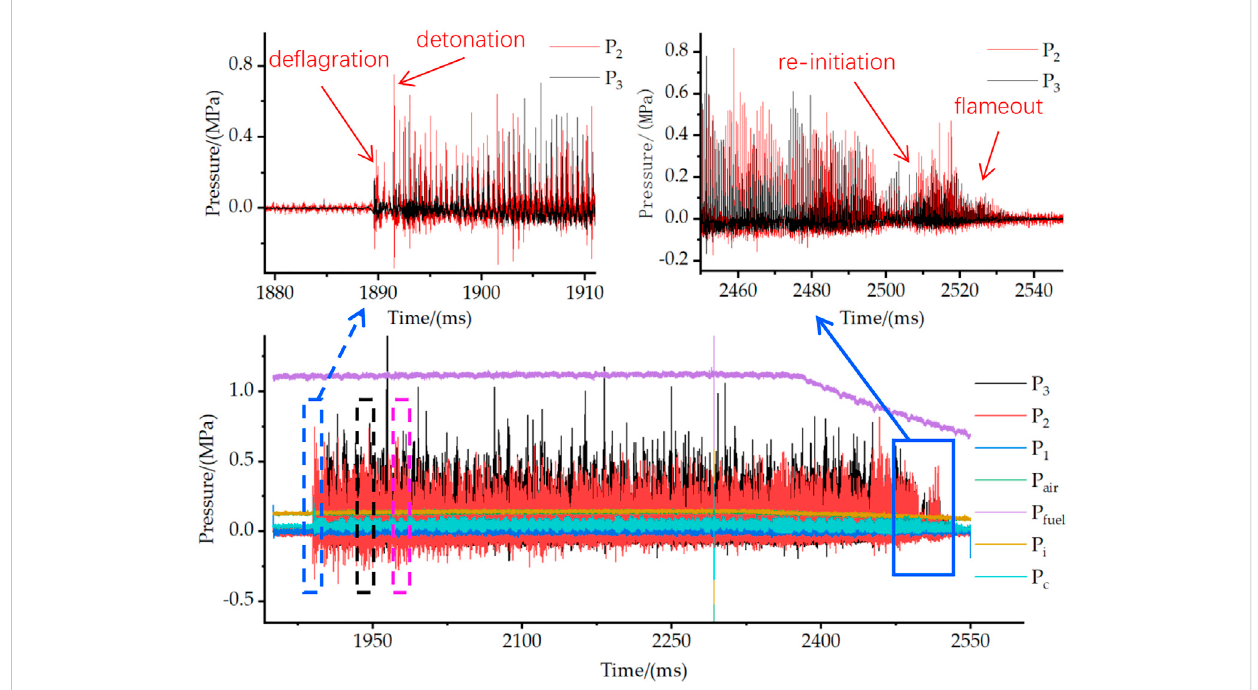
FIGURE 4 Results of operating at ER = 1.2 and l w = 4 mm.